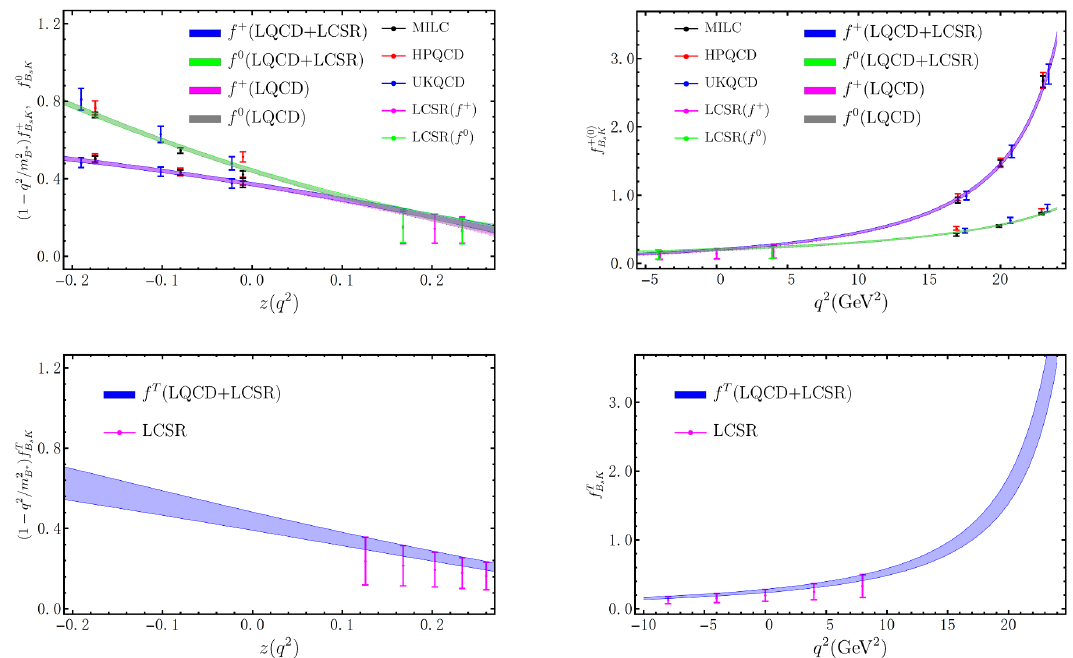
Figure 11 . Theory predictions for the complete set of the semileptonic B s → K form factors versus z (left panel) and versus q 2 (right panel) in the entire kinematic region obtained by carrying out the combined BCL z -fit of the updated LCSR (from this work) and lattice simulation (merely for the two form factors f + , 0 ( q 2 ) from [4, 8, 11]) data points. We further display the yielding numerical B s K results for the vector and scalar form factors by performing an independent z -series fit against the “ only lattice QCD ” data points [4, 8, 11] exclusively for the illustration